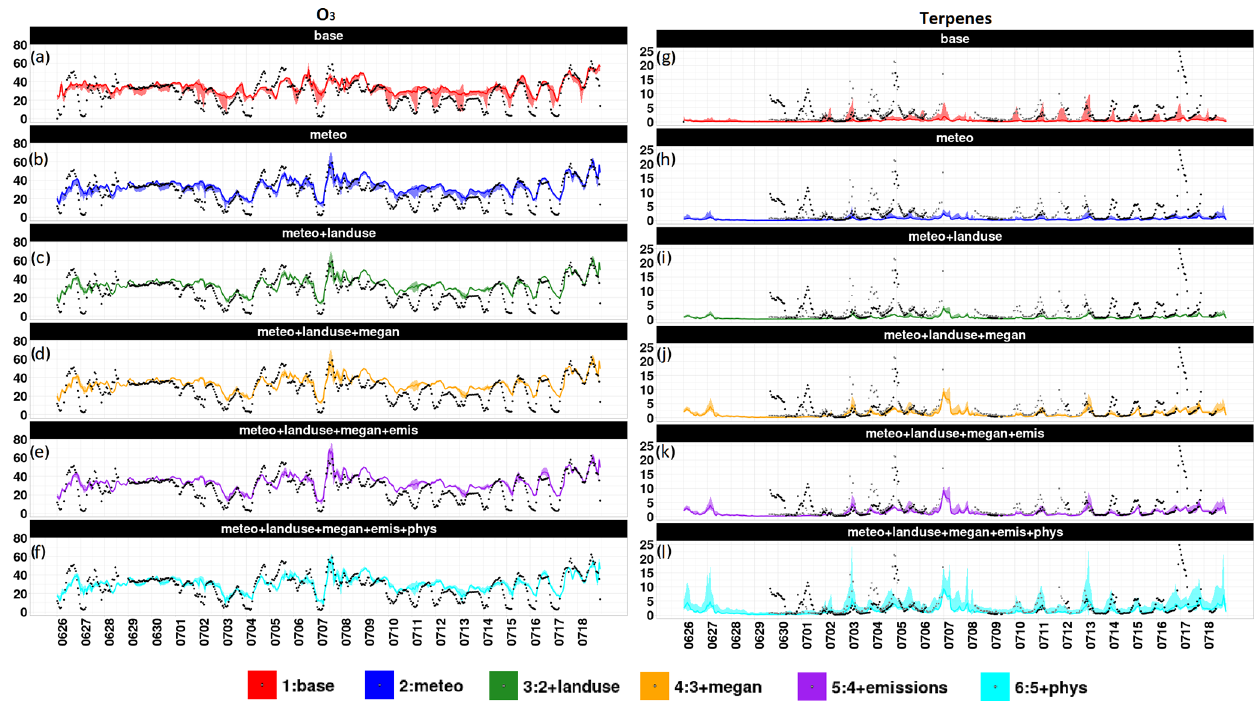
Figure 6. Time series for O 3 and terpene concentrations (all inppb) for all the sensitivity cases explained in Sect. 3 and Table 2. The color scheme is shown at the bottom. The name of each case is written above each time series. Time series for other species are provided in the